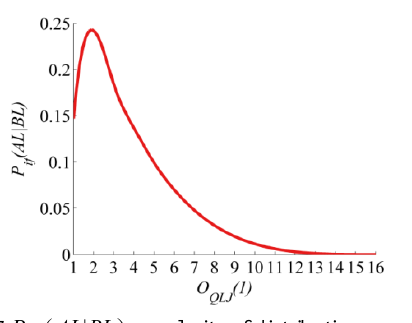
Fig.7 P if （ AL|BL ） regularity of distribution ， n v =50 The probability of the queue position order of